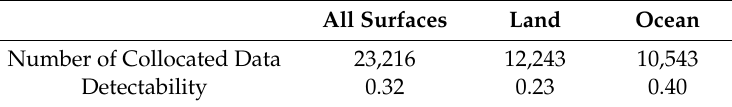
Table 1. Number of unique dust or polluted dust layers from CALIPSO collocated with GOSAT within 50 km/15 min for all (including mixed), land, ocean surfaces, with detectability defined by the ratio of the number of data for which dust layers are detected using the slicing method to the number of collocated CALIPSO